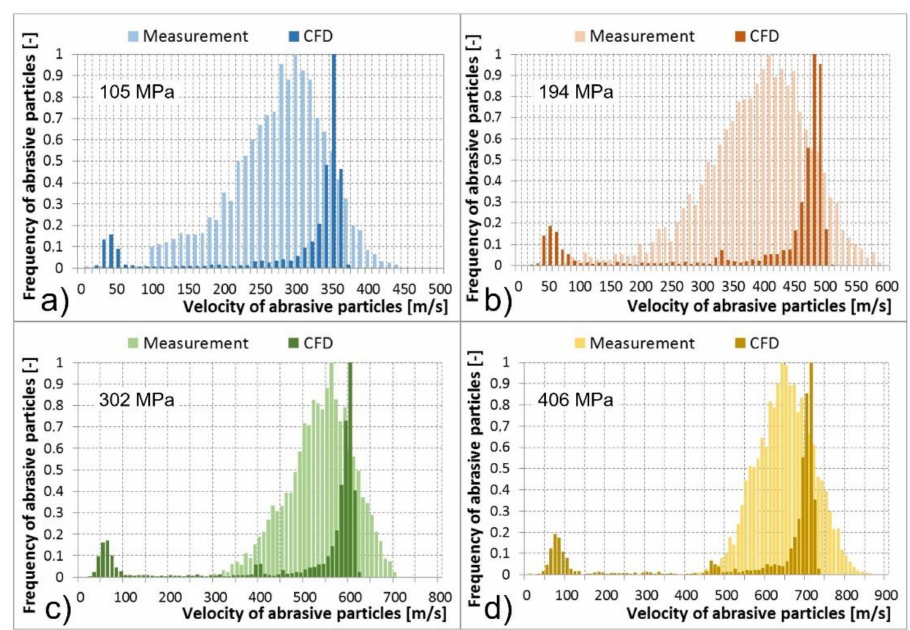
Figure 14. Abrasive particle velocities at the abrasive nozzle outlet, measurement vs. computational models for determined water pressure levels, and abrasive particle mass flow rate of 200 g/min: ( a ) 105 MPa; ( b ) 194 MPa; ( c ) 302 MPa; ( d ) 406 MPa.